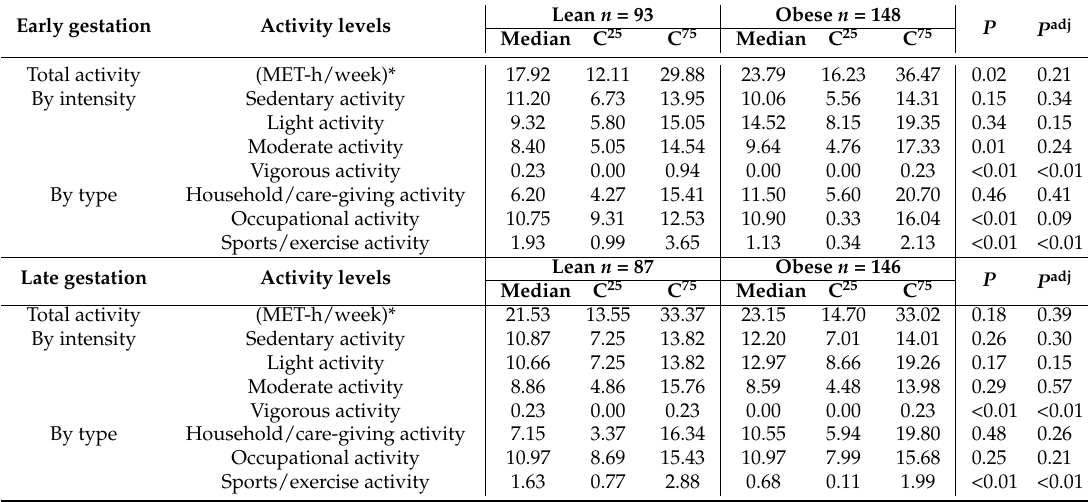
Table 4. Reported physical activity in early and late gestation in lean and very severely obese